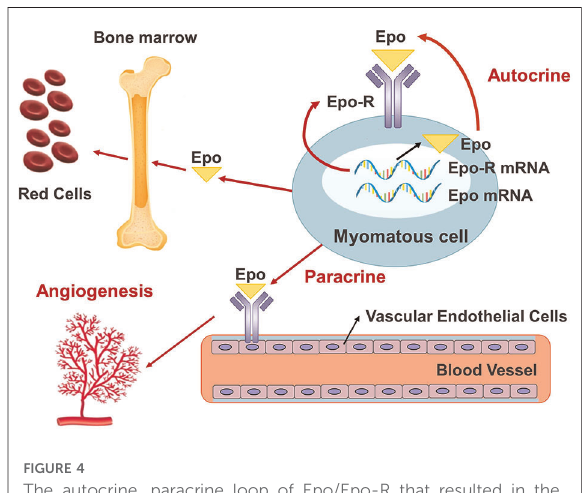
FIGURE 4 The autocrine, paracrine loop of Epo/Epo-R that resulted in the angiogenesis, excessive growth of the leiomyoma, and erythrocytosis. EPO, erythropoietin; Epo-R, erythropoietin